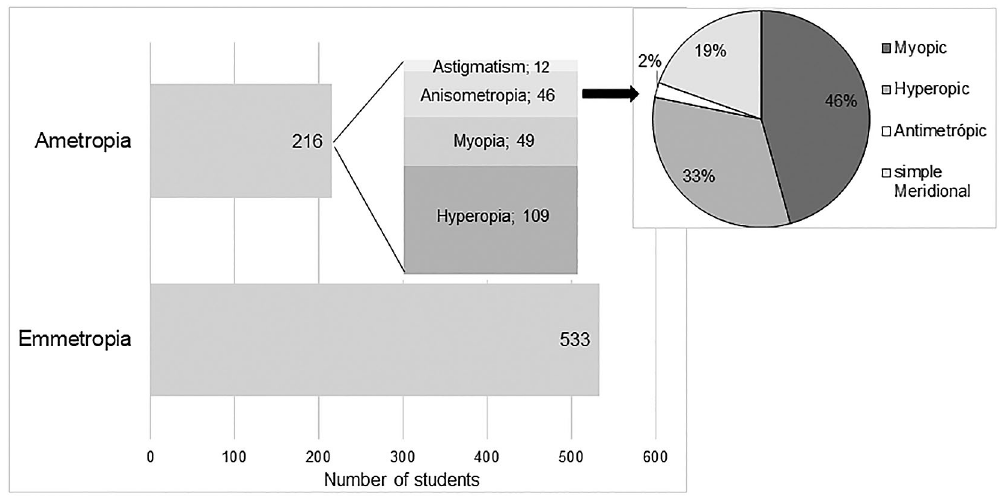
Figure 1. Refractive error distribution.